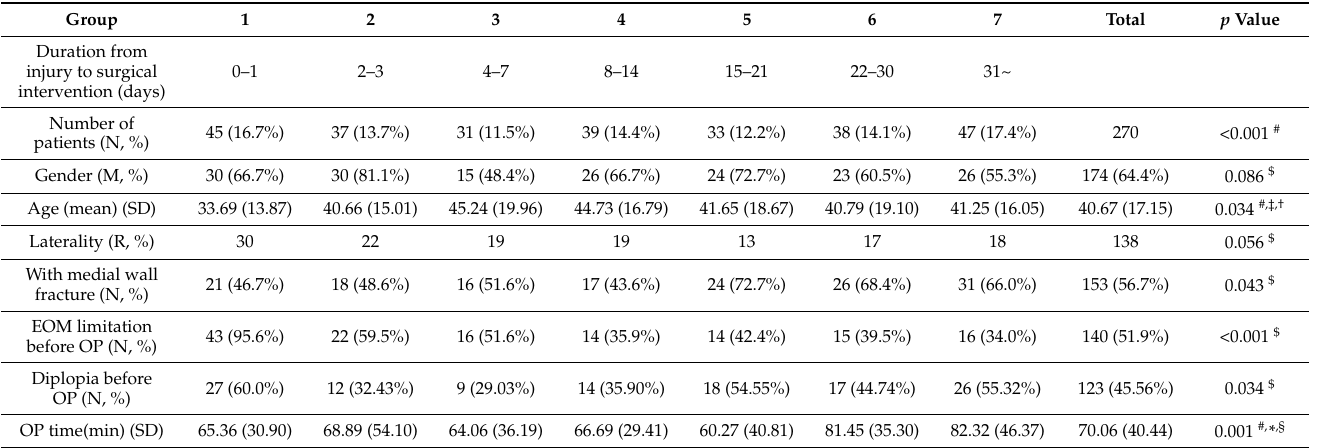
Table 1. Demographic data and characteristics of patients with orbital floor fractures based on different groups of surgical intervention